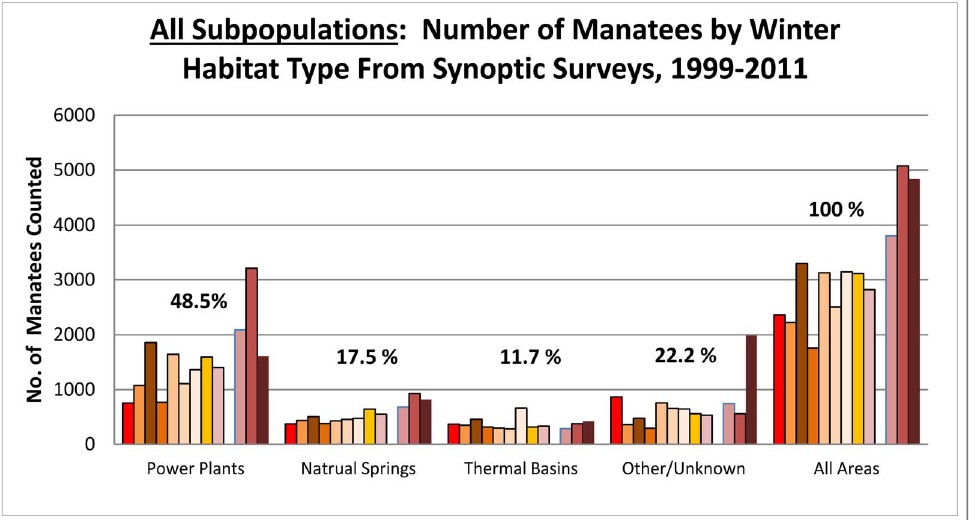
Figure 3. Proportions of manatees at power plants, natural springs, passive thermal basins and other sites during synoptic surveys from 1999 to 2011. (Bars indicate the number of manatees counted each year over the 13-year study period; no survey was conducted in 2008.)